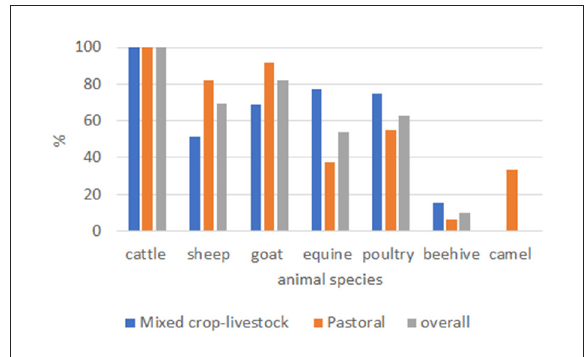
(Figure 2). Additionally, 9.64% of the participants had beehives in their backyards. Regarding species diversity, the majority (63.5%) of the households owned more than three animal species on their